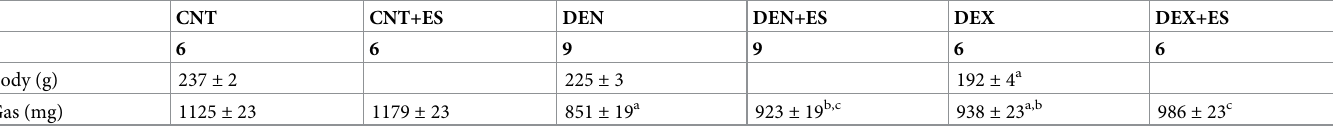
Values are means ± SEM. CNT, control; DEN, denervation; DEX, dexamethasone; ES, neuromuscular electrical stimulation; n, number of samples; Gas,